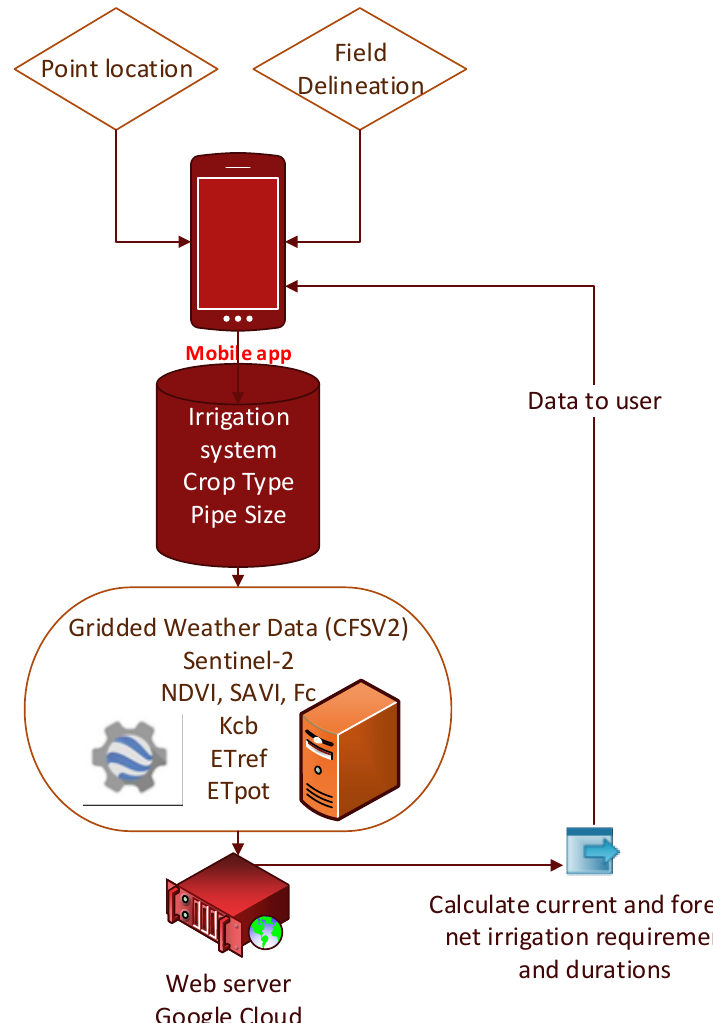
Figure 1. The workflow of the AgSAT application.